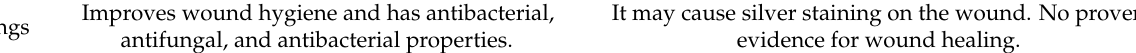
Table 1. Advantages and limitations of dressings for the treatment of diabetic wounds [31].